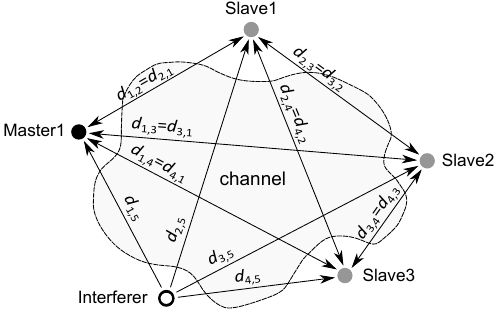
Figure 15. Propagation of the signals through the channel between the